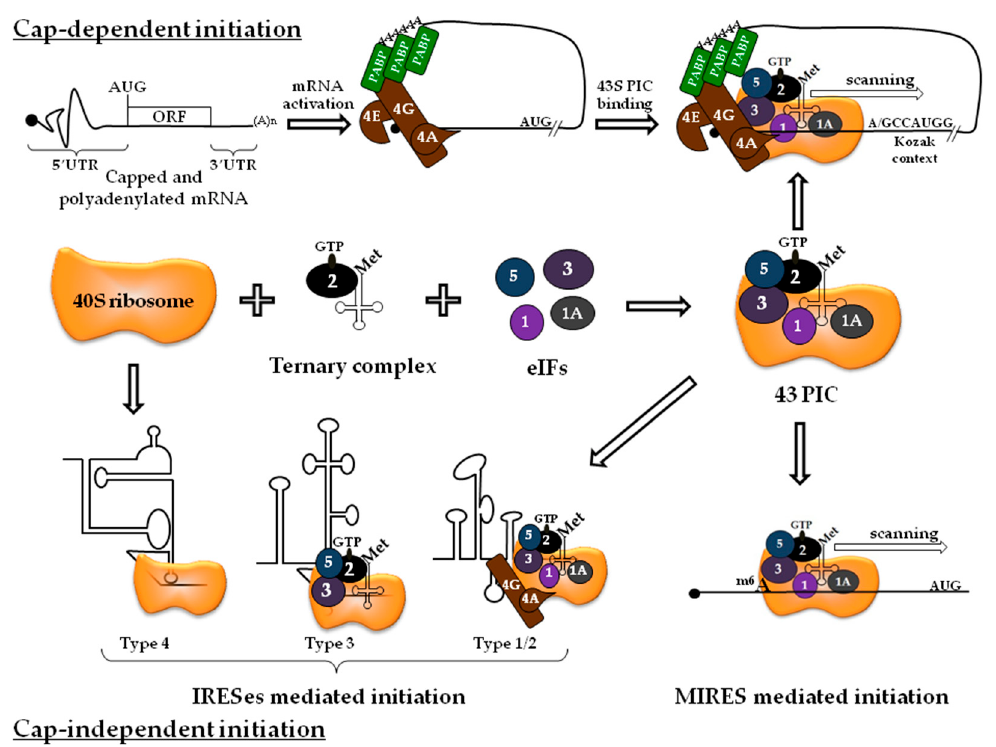
Figure 1. Model for cap-dependent and -independent ribosome recruitment on mRNAs. Interaction of the ternary complex to the 40S ribosome is enhanced in the presence of eIFs to form the 43S pre-initiation complex (PIC). 43S PIC can be recruited on activated mRNAs by the eIF4F complex composed of the eIF4E cap binding protein, the eIF4G scaffold protein, and the eIF4A helicase. 43S PIC bound to the mRNA scans the 5 ′ untranslated region (UTR) to initiate translation at the AUG initiation codon. This is the cap-dependent translation initiation mechanism. Cap-independent ribosome attachment is largely mediated by IRESes in which components of the 43S PIC can interact directly with some RNA structures. The requirement of eIFs to promote ribosome attachment depends of the type of the IRES: briefly, type 1 and 2 IRESes require all eIFs except eIF4E, type 3 IRESes do not need any of the eIF4F complex components, and type 4 IRESes do not rely on any eIFs nor Met-tRNAi. Finally, the 43S PIC can bind m 6 A located into the 5 ′ UTR.